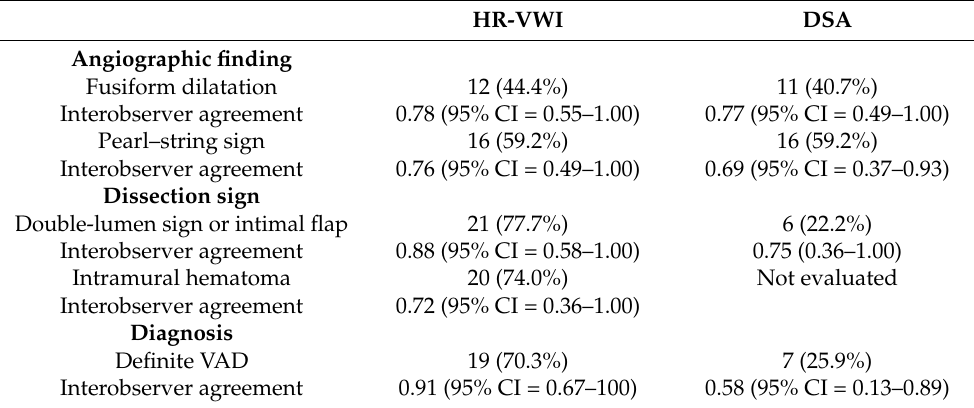
Table 4. Comparison of radiological features and performance of vertebral artery dissection between high-resolution vessel wall imaging with MR angiography and digital subtraction